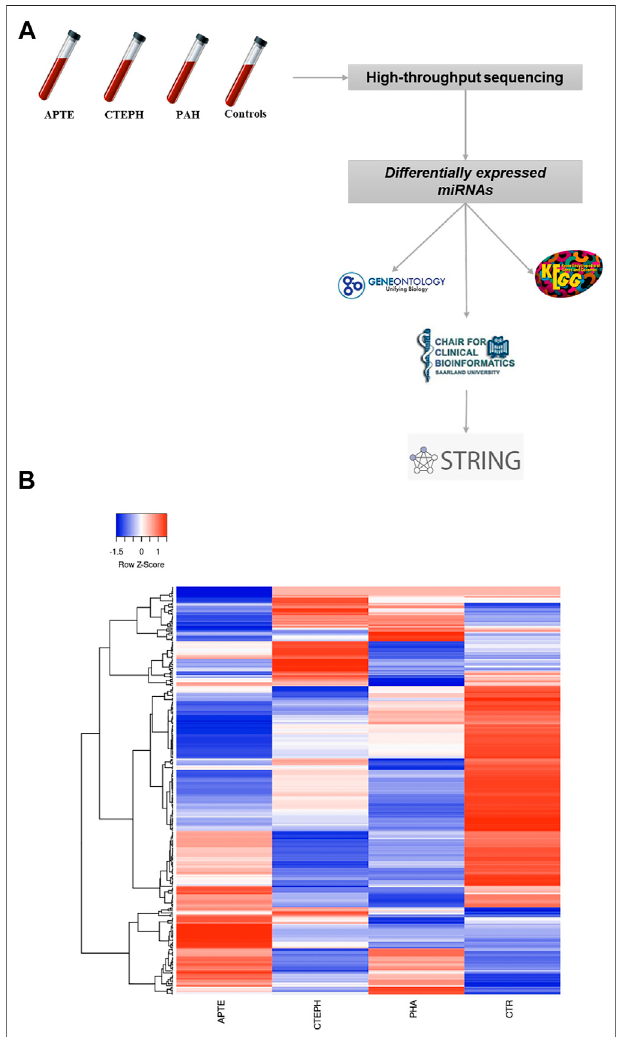
FIGURE 1 | (A) Flowchart showing the strategy for detection of differentially expressed miRNAs through next-generation technology. (B) Hierarchical clustering of the four experimental groups based on their miRNA expressionpatterns( p adj < 0.05,|log2(foldchange)| > 1) fi lteringofnext- generation sequencing results. 299 miRNAs were subjected to hierarchical clustering by average linkage method calculating with Pearson distance. Green and red colors represent increased and decreased expression levels (transformed into z -scores), respectively, when compared with the average level of each miRNA. Columns and lines represent samples and miRNA, respectively. APTE, acute pulmonary thromboembolism; CTEPH, thromboembolic pulmonary hypertension; PAH, idiopathic pulmonary hypertension; and CTR, Controls.